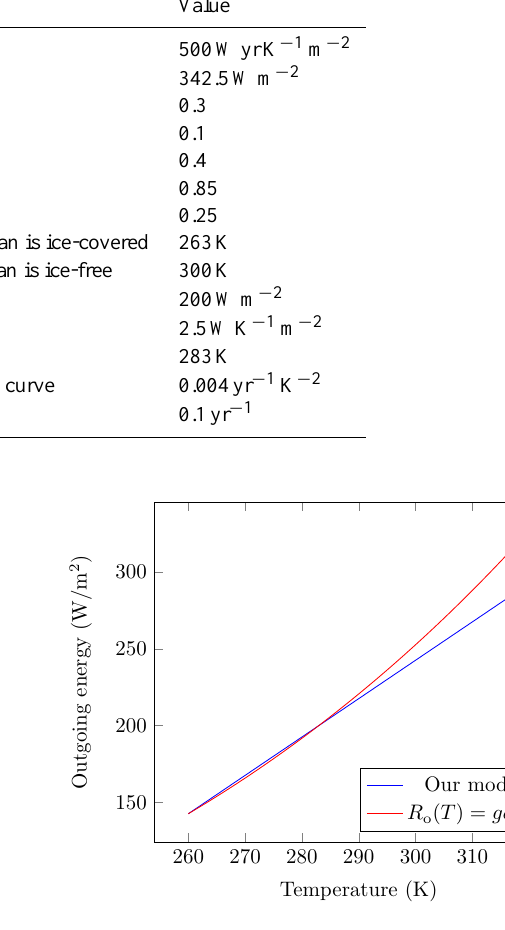
Figure 3. Outgoing energy as a function of temperature for different